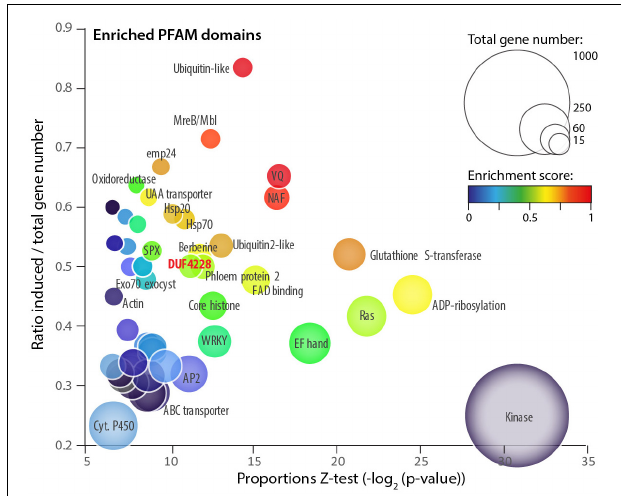
FIGURE 1 | Protein domains enriched among A. thaliana genes upregulated upon S. sclerotiorum inoculation. Each bubble shows one of 54 PFAM domains significantly enriched (proportion test p -value < 0.01) in induced genes (LFC > 1.5, p -value < 0.01). Bubbles are sized according to the total number of genes containing the domain in the A. thaliana genome. Enrichment is shown as the p -value of a proportion Z -test for enrichment ( X -axis), the ratio between the number of induced/total genes ( Y -axis) and a composite enrichment score (color scale, see the section “Materials and Methods”). The DUF4228 domain is labeled in bold red. Associated raw data corresponds to Arabidopsis thaliana samples from GEO accession number